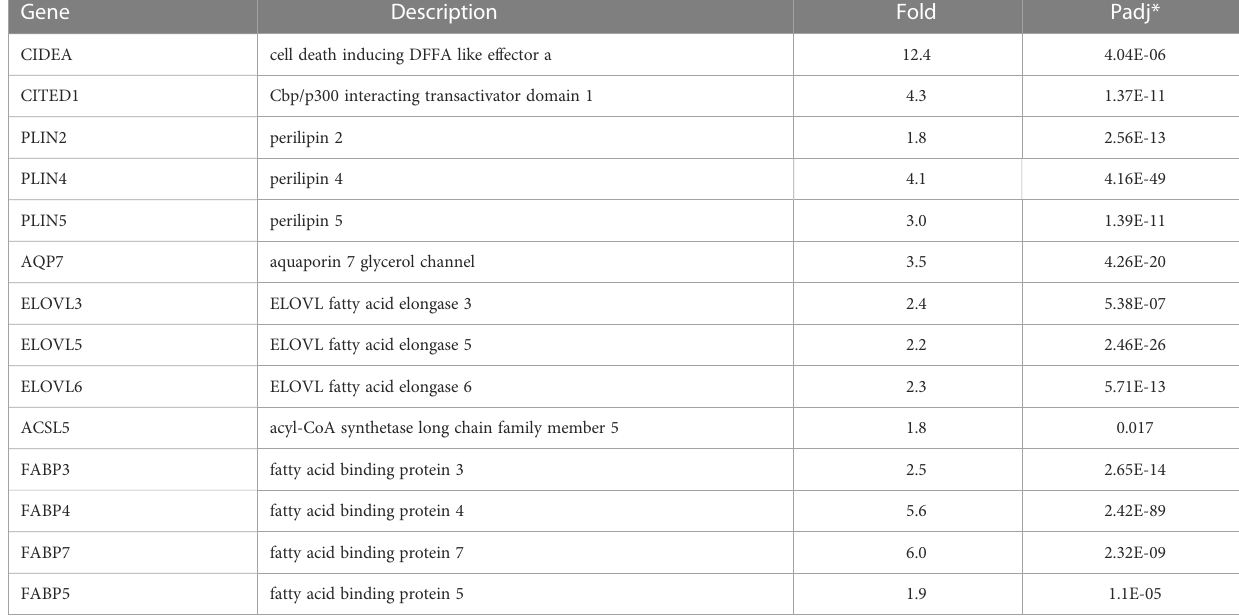
TABLE 1 NRBC-induced genes associated with brown/beige phenotype previously shown as upregulated by synthetic PPAR g and PPAR a activators.